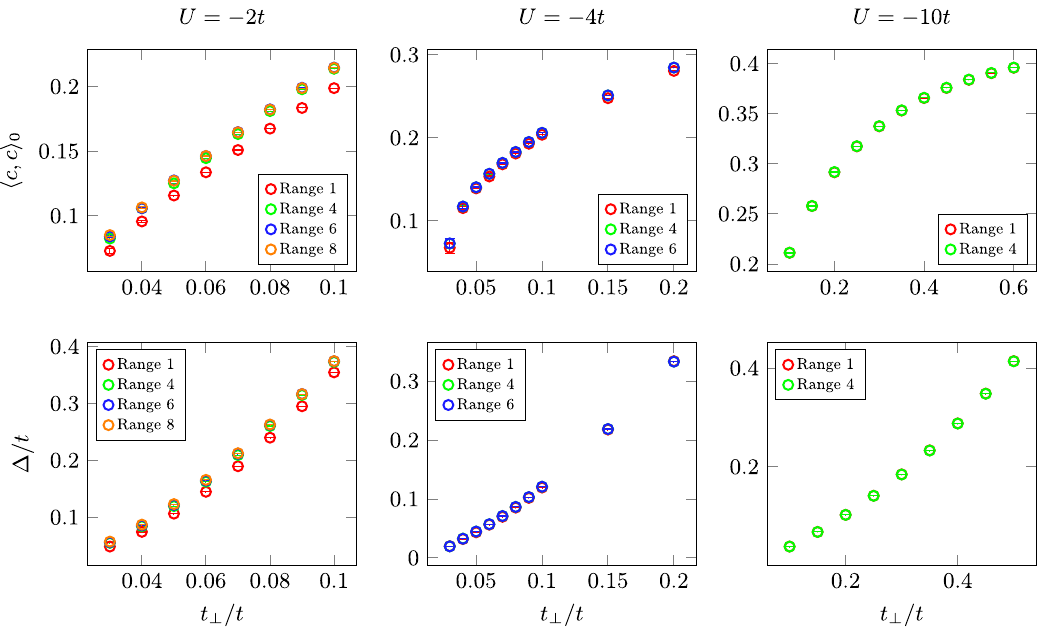
FIG. 10. Range dependence of the order parameter defined in Eq. (43) and first excitation energy defined in Eq. (26) for different values of interaction U=t ¼ − 2 ; − 4 ; − 10 and density n ¼ 0 . 5 . Notably, the difference between the two largest ranges is not visible which indicates sufficient range in the